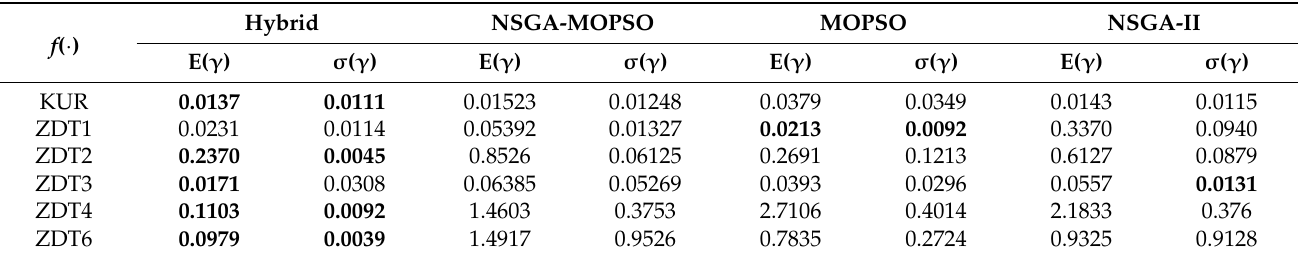
Table 3. Statistical results of convergence metric.